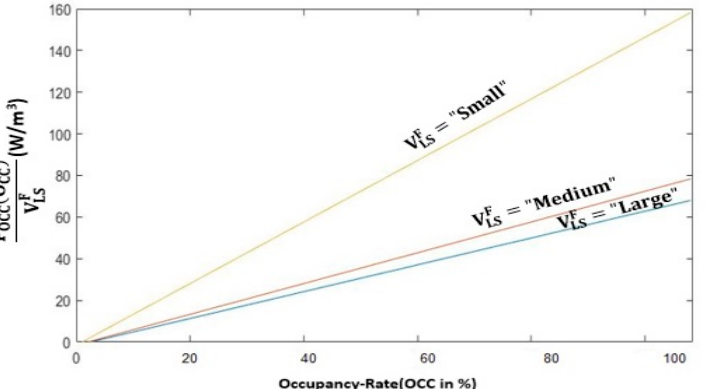
Figure 3. P OCC V F LS (W/m 3 ) versus the occupancy rate for the three considered categories of living spaces of building A. P occ : Power of occupations; V F LS : “fuzzy value of the living spaces volume.